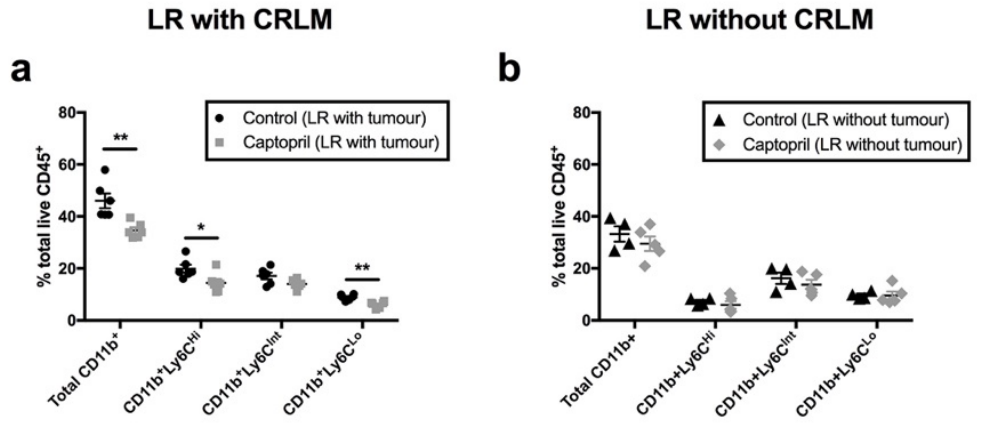
Figure 5. The renin–angiotensin system inhibitor (RASi) captopril reduces CD11b + myeloid-derived suppressor cell populations within the regenerating liver (LR) following tumour induction, down to baseline levels observed in regenerating liver without tumour. One group of mice underwent surgical induction of colorectal liver metastasis via splenic injection (Day 0) and one group of mice did not undergo tumour induction. From Day 4 to Day 16, intraperitoneal injections of captopril 250 mg/kg/day or saline (control) were administered to all mice in both groups. On Day 7, all mice un- derwent a 70% partial hepatectomy. All mice were culled on Day 16, and liver and tumour speci- mens were retrieved for flow cytometry: ( a , b ) proportion of total CD45 + myeloid cells that were CD11b + , CD11b + Lyc6C Hi , CD11b + Ly6C Int , and CD11b + Ly6C Lo in livers of mice following tumour in- duction and partial hepatectomy ( a ) and in livers of mice following partial hepatectomy alone (no tumour) ( b ). Data are representative of two independently performed murine experiments (control n = 6 mice, captopril n = 6 mice). Significant differences were determined by an unpaired, two-tailed Student’s t -test. p < 0.05 (*), p < 0.01 (**).